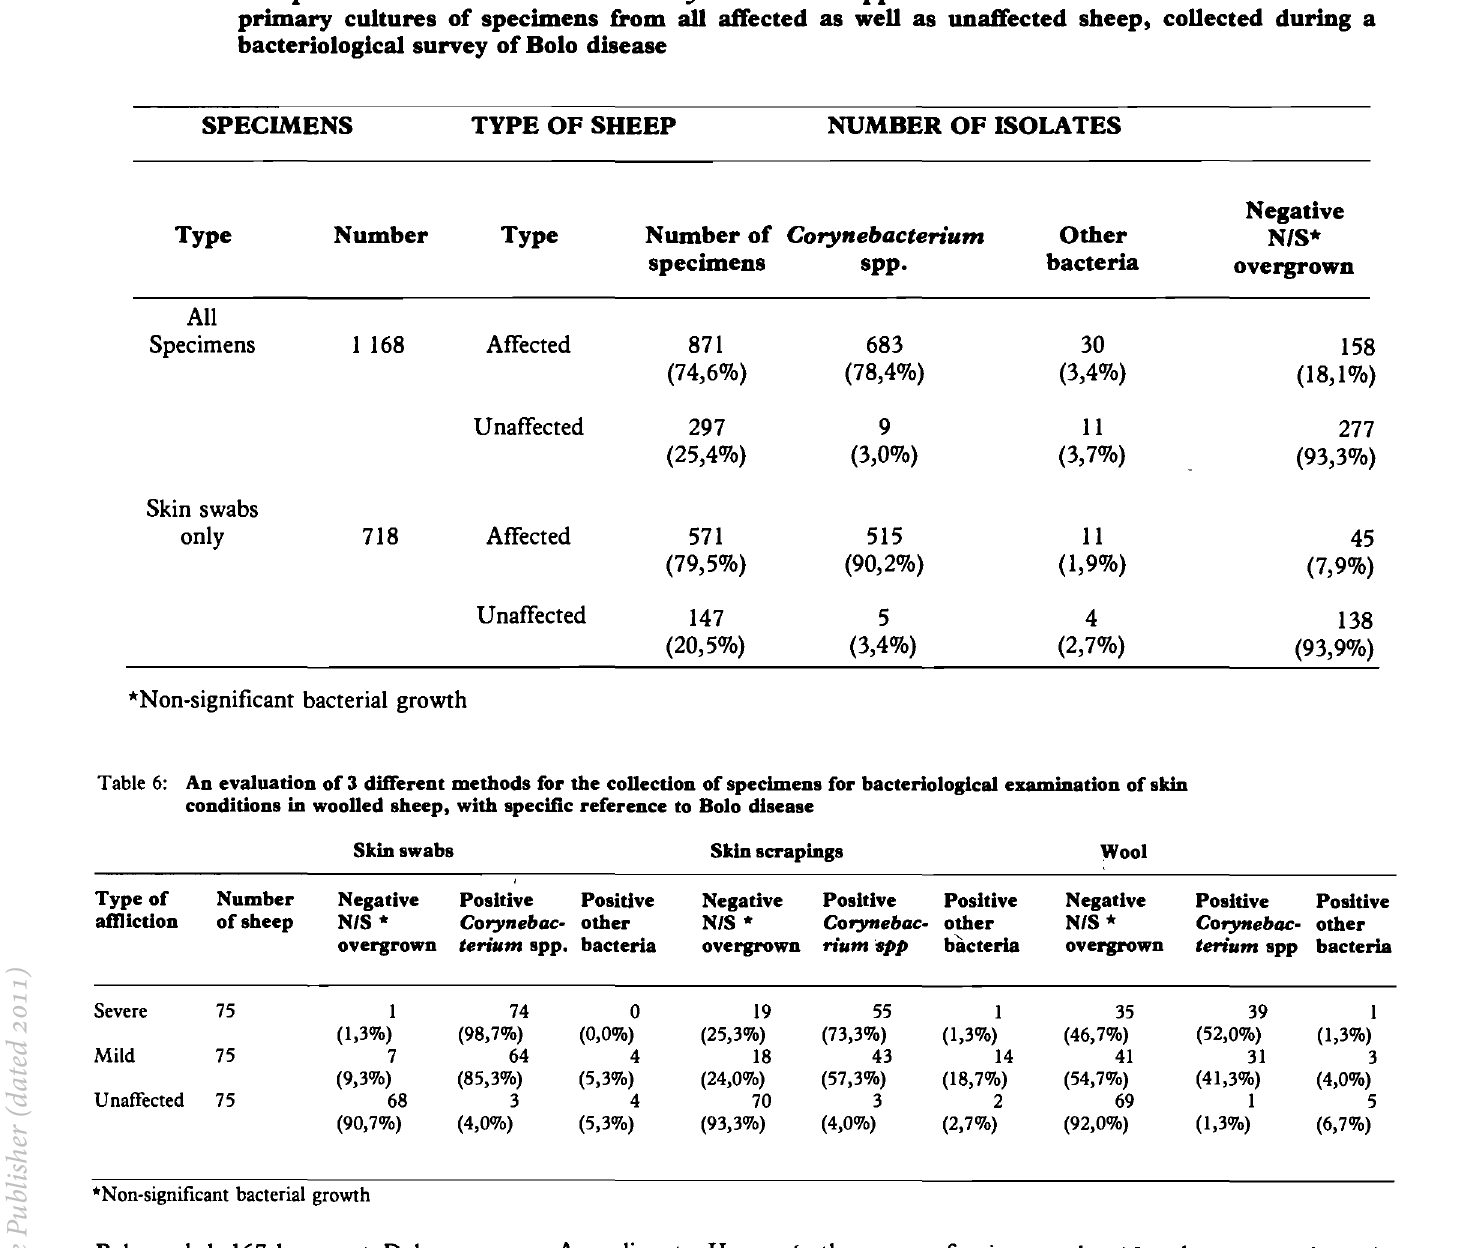
Table 6: An evaluation of 3 different methods for the collection of specimens for bacteriological examination of skin conditions in woolled sheep, with specific reference to Bolo disease Skin swabs Skin scrapings Type of of